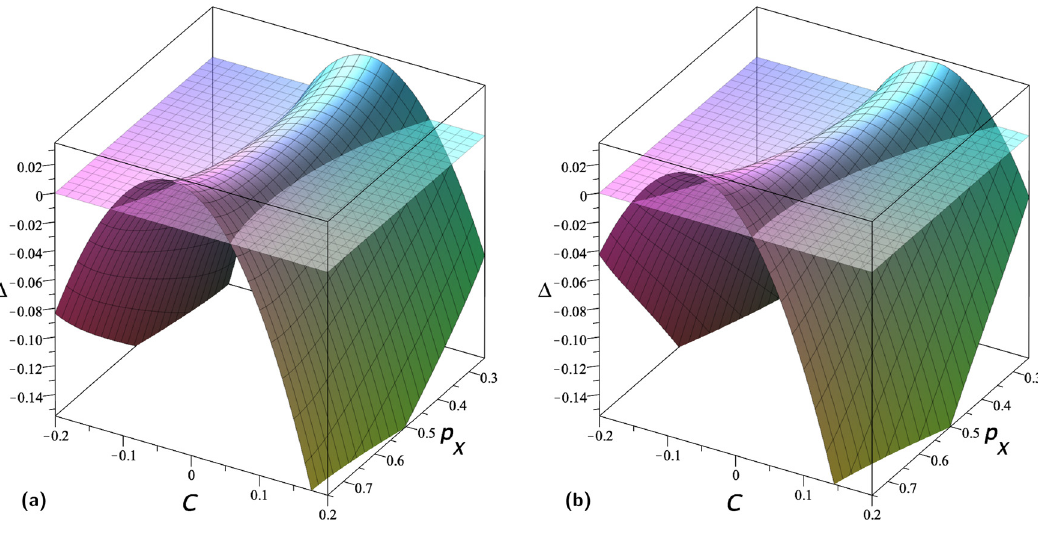
Figure 3: The relative di ff erence in variance of the two estimators for two interaction strengths. ( a ) D 1